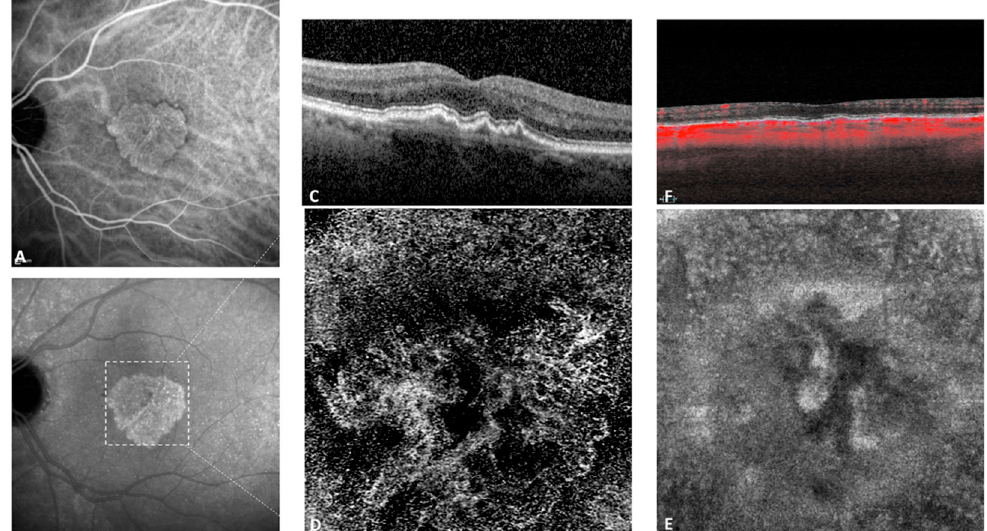
Figure 2. Multimodal imaging of an 80 years old patient with subclinical macular non-exudative neovascularization on the study eye. Intermediate ( A ) and late ( B ) indocyanine green angiography (ICGA) frames, revealing a hyperfluorescent plaque in the late frame. Spectral domain optical coherence tomography (SD-OCT) ( C ) showed a shallow pigment epithelial detachment (PED). The outer retina to choriocapillaris (ORCC) segmentation of the 3 × 3 mm 2 OCTA ( D ) revealed the presence of a high flow neovascular network. ( E ). Corresponding structural en face image at the choriocapillaris and ( F ) Corresponding B-scan with the choriocapillaris segmentation.